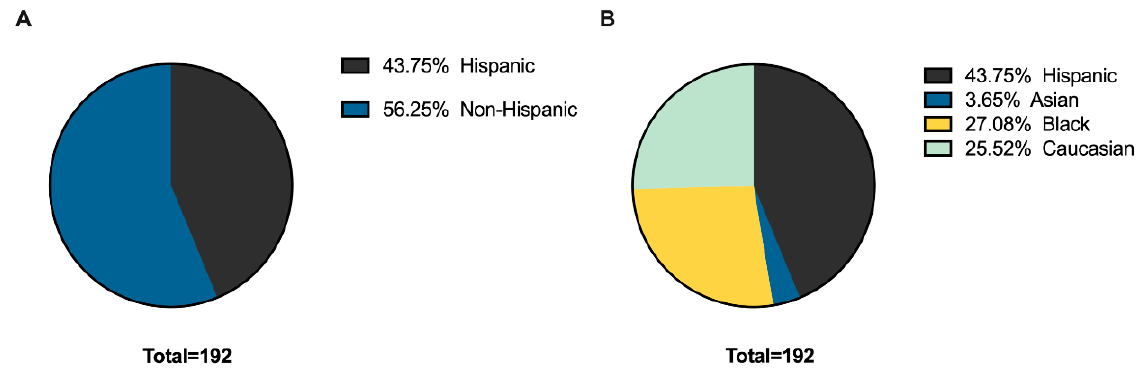
Figure 1. Self ‐ reported ( A ) ethnicity and ( B ) race. Figure 1. Self-reported ( A ) ethnicity and ( B )